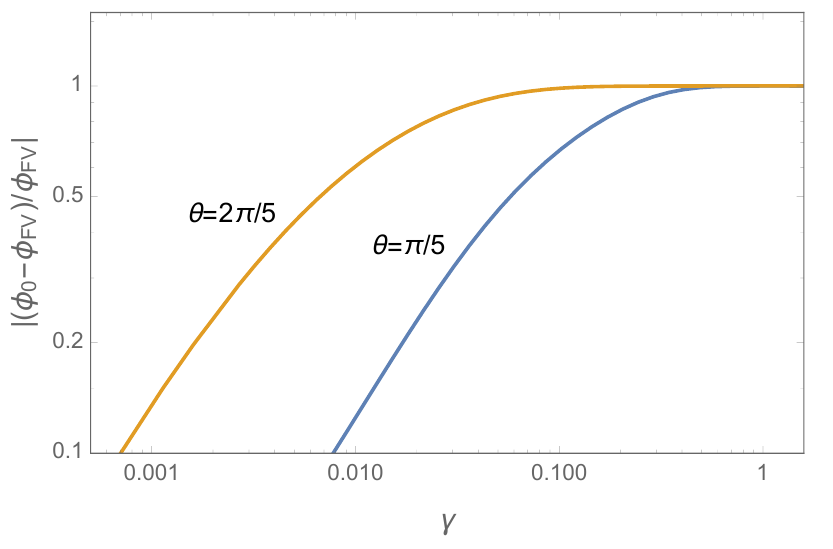
Figure 2 . Shift of the tunneling point ( j ( (cid:30) 0 (cid:0) (cid:30) FV ) =(cid:30) FV j ) as a function of (cid:13) ( (cid:17) U L =U H ) for (cid:18) = (cid:25)= 5 (blue line) and 2 (cid:25)= 5 (orange